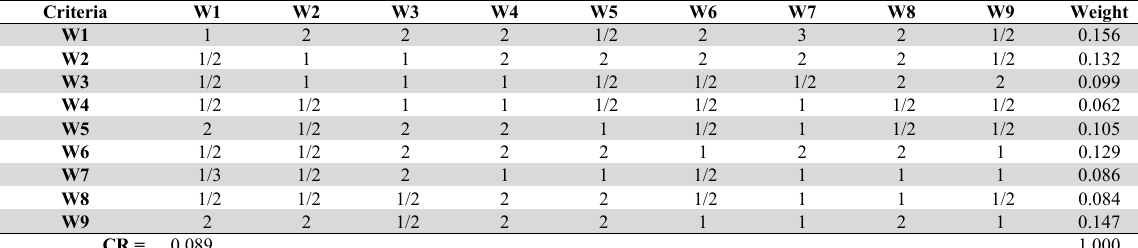
Pairwise comparison matrix aggregation for weaknesses aspects Criteria